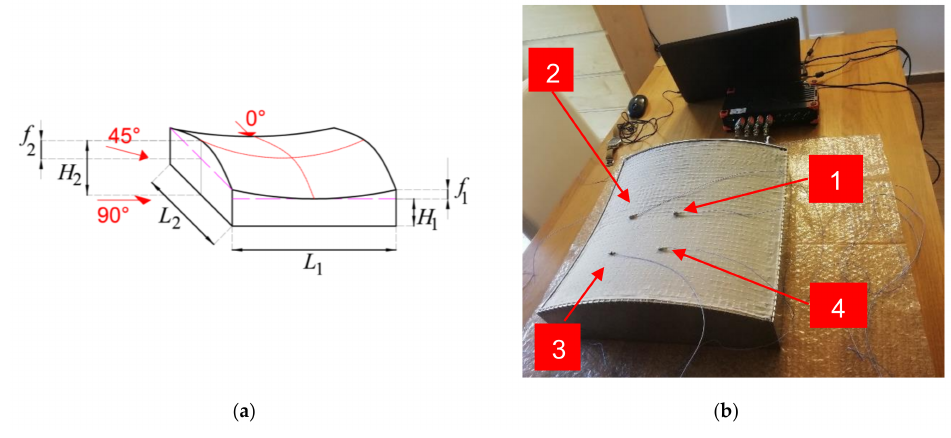
Figure 2. Geometry ( a ) and test model with sensor position ( b )